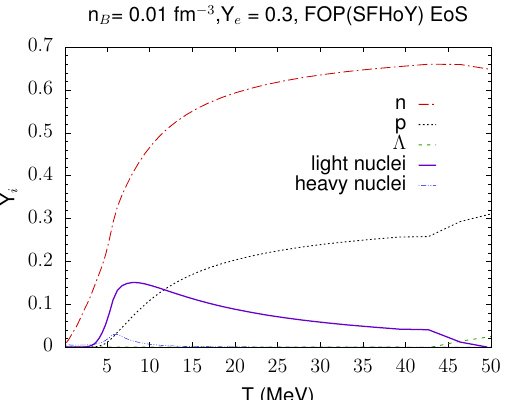
Figure 3. Different particle fractions as function of temperature for the FOP(SFHoY) EoS at n B = 0.01 fm − 3 and Y e = 0.3.